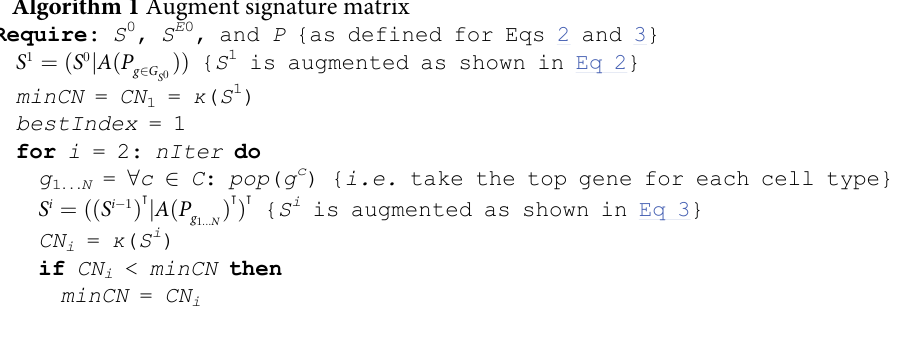
Algorithm 1 Augment signature